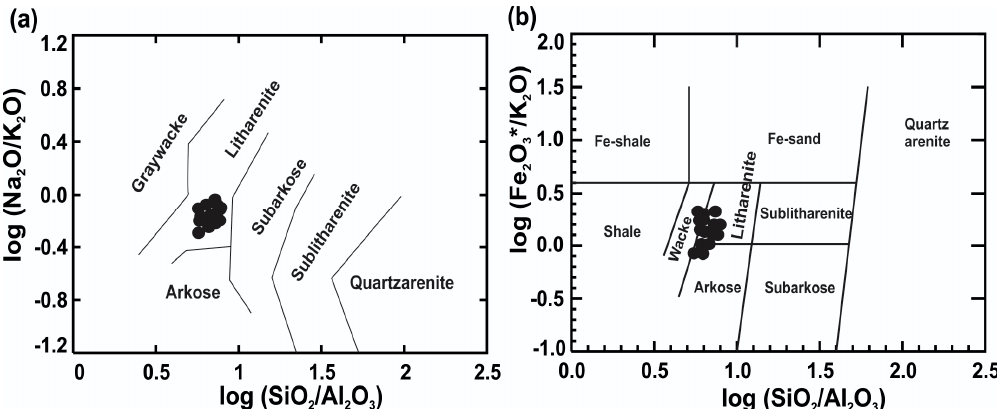
Figure 4. Geochemical classifications of the Brahmaputra River sediments ( a ) log (Na 2 O/K 2 O) versus log (SiO 2 /Al 2 O 3 ) classification diagram after Pettijohn et al. [34] and ( b ) log (Fe 2 O 3 */K 2 O) versus log (SiO 2 /Al 2 O 3 ) classification diagram after Herron [33]. Brahmaputra River sediment samples are represented by the black dots.